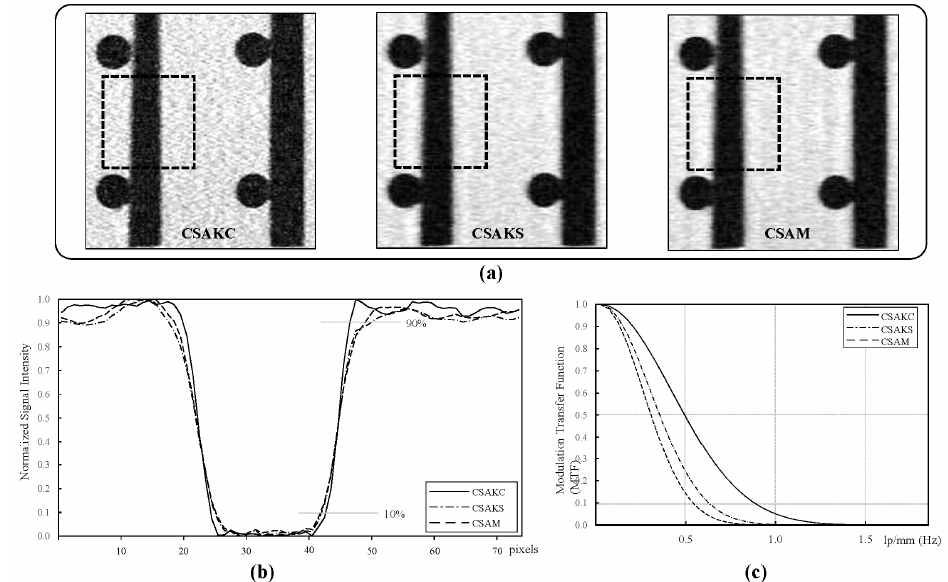
Figure 4. Mean line profiles and modulation transfer function (MTF) curves of CSA images with 25% undersampling ratio in the brain phantom. ( a ) CSAM, CSAKS, and CSAKC images and ROIs selected for further analysis; ( b ) the mean line profiles of each CSA image within the ROI; ( c ) MTF curves of each CSA image. The line pairs per millimeter (lp/mm) were lowest for CSAM, followed by CSAKS and CSAKC for the same relative MTF value, suggesting that CSAKC showed the best contrast between tissues.